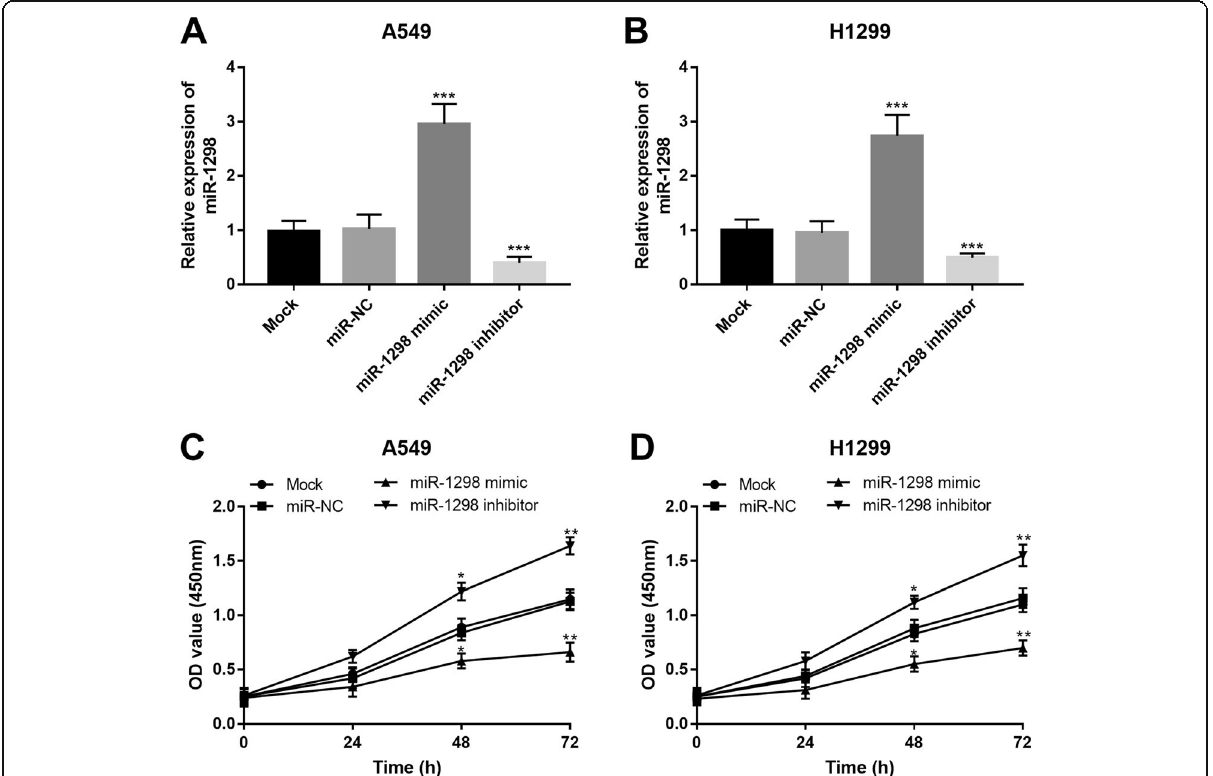
Fig. 3 In vitro regulation of miR-1298 and its effect on NSCLC cell proliferation in A549 and H1299 cell lines. A and B. miR-1298 expression was promoted by the miR-1298 mimic, but was suppressed by the miR-1298 inhibitor. C and D. Cell proliferation was promoted by the downregulation of miR-1298, while was inhibited by the upregulation of miR-1298. * P < 0.05, ** P < 0.01 *** P < 0.001